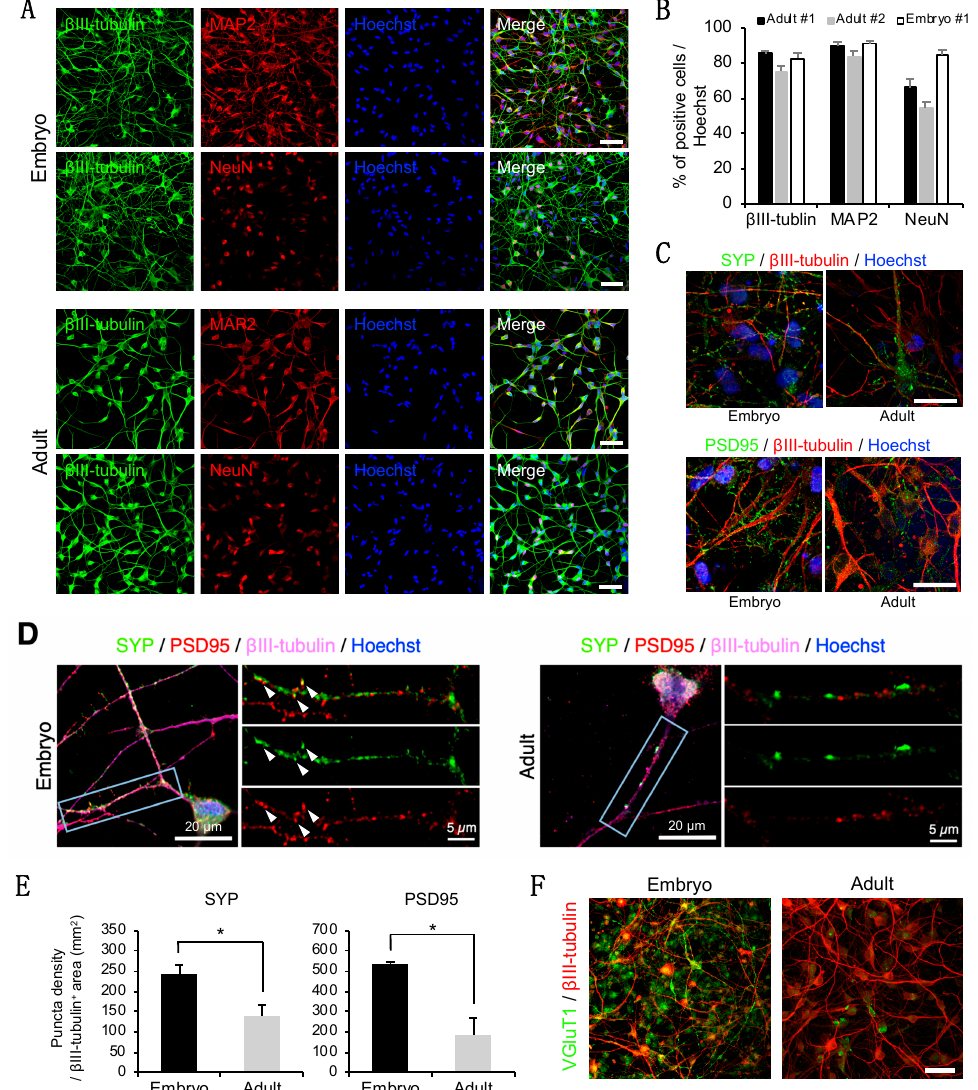
Figure 2. Neuronal marker expression of neuron-like cells by immunocytochemistry. ( A ) Immunostaining for pan-neuronal markers in embryonic and adult marmoset neuron-like cells at post induction day (PID) 15. The cell bodies and neurites were positive for class III β -tubulin ( β III-tubulin) and microtubule-associated protein 2 (MAP2). The nuclei were positive for the mature neuronal marker NeuN. Scale bars, 50 µ m. ( B ) Quantification of the number of neuronal marker-positive cells in neuron-like cells derived from fibroblasts from two adult marmosets and an embryonic marmoset ( n = 3 biological replicates per sample). Data are represented as the mean ± standard error of the mean. ( C ) Co-immunostaining for β III-tubulin and synaptic markers (synaptophysin [SYP] or postsynaptic density protein 95 [PSD95]). Scale bars, 20 µ m. ( D ) Co-immunostaining for β III-tubulin, SYP, and PSD95. Enlarged images of the neurite area enclosed by the rectangle are shown on the right. The arrowheads indicate the colocalization of the immunostaining-positive puncta. ( E ) Quantification of SYP- and PSD95-immunostained puncta. The number of SYP- or PSD95-positive puncta per β III-tubulin-positive area (mm 2 ) was counted ( n = 3 biological replicates per sample). Differences between means were compared using Student’s t -test. * p < 0.05. ( F ) Immunostaining for the excitatory synaptic marker vesicular glutamate transporter 1 (VGluT1) in embryonic and adult marmoset neuron-like cells at PID 14. Scale bar, 50 µ m.